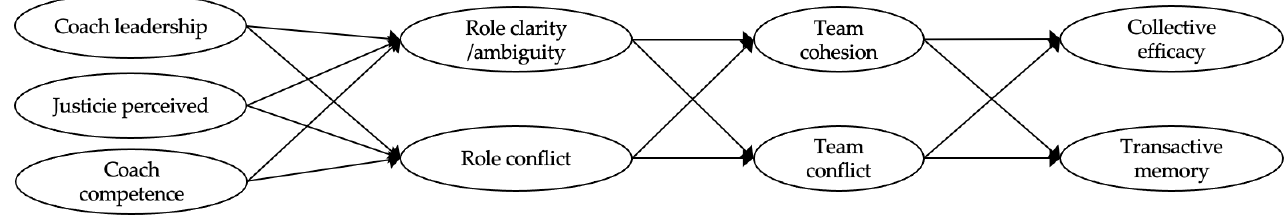
Figure 3. The hypothesized Model 2 of the relationships among variables.